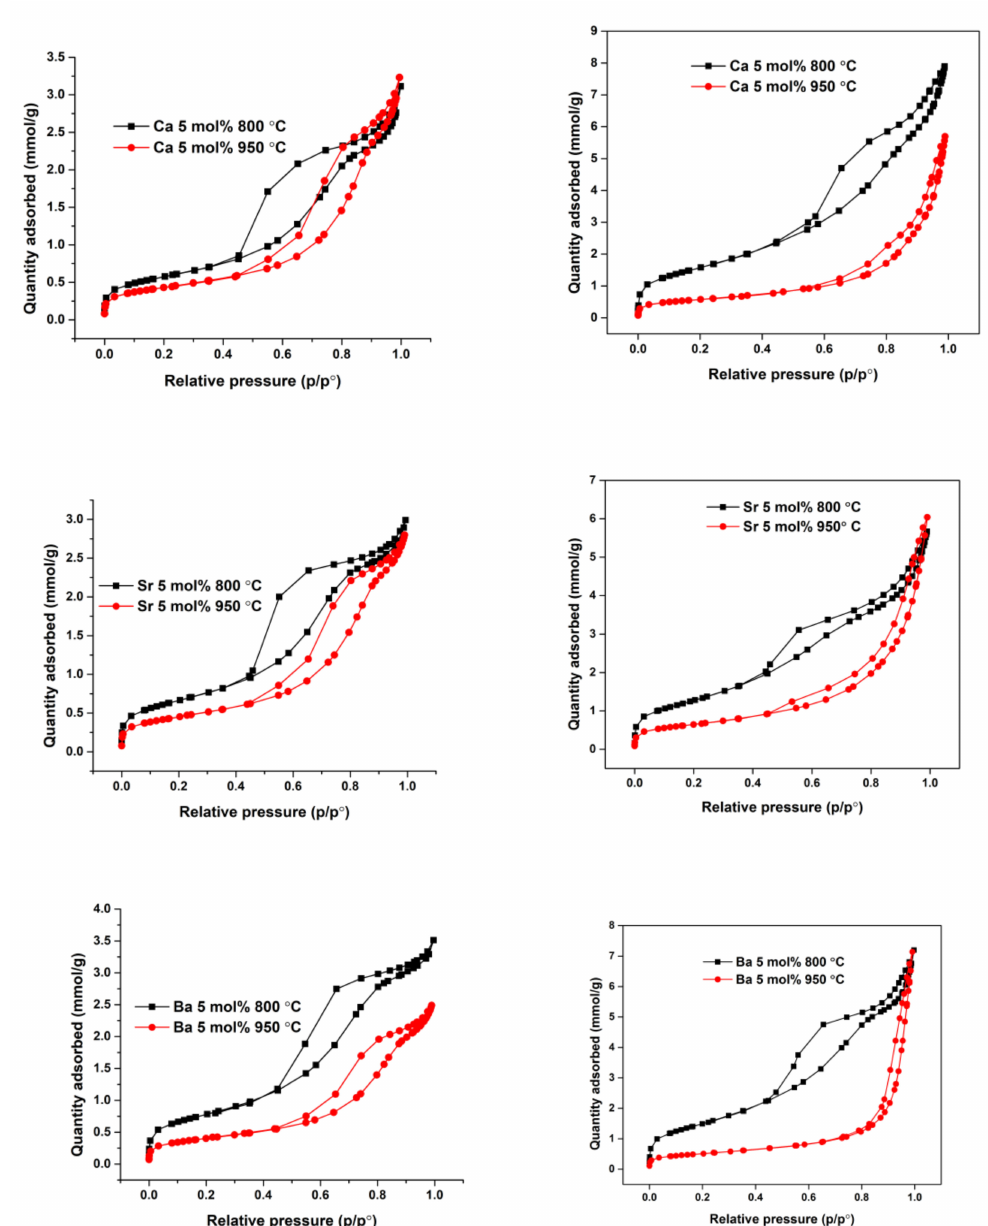
Figure 13. Nitrogen adsorption–desorption isotherms of mixed metal oxides (MMO) obtained by heating the Mg 1.95 Ca 0.05 / Al 1 precursor gels ( top, left ), by heating the Mg 1.95 Ca 0.05 / Al 1 LDHs ( top, right ), by heating the Mg 1.95 Sr 0.05 / Al 1 precursor gels ( middle, left ), by heating the Mg 1.95 Sr 0.05 / Al 1 LDHs ( middle, right ), by heating the Mg 1.95 Ba 0.05 / Al 1 precursor gels ( bottom, left ), and by heating the Mg 1.95 Ba 0.05 / Al 1 LDHs ( bottom, right ) at 800 ◦ C and 950 ◦